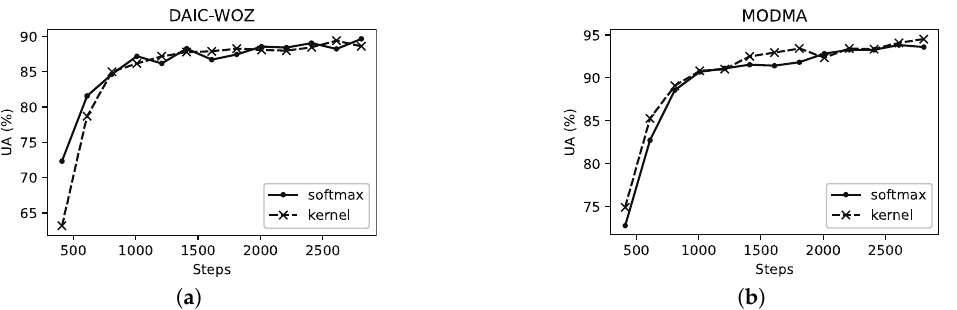
Figure 4. The unweighted accuracies (%) of the transformer module with softmax and kernel setups for different iteration steps in training on ( a ) DAIC-WOZ and ( b ) MODMA datasets.